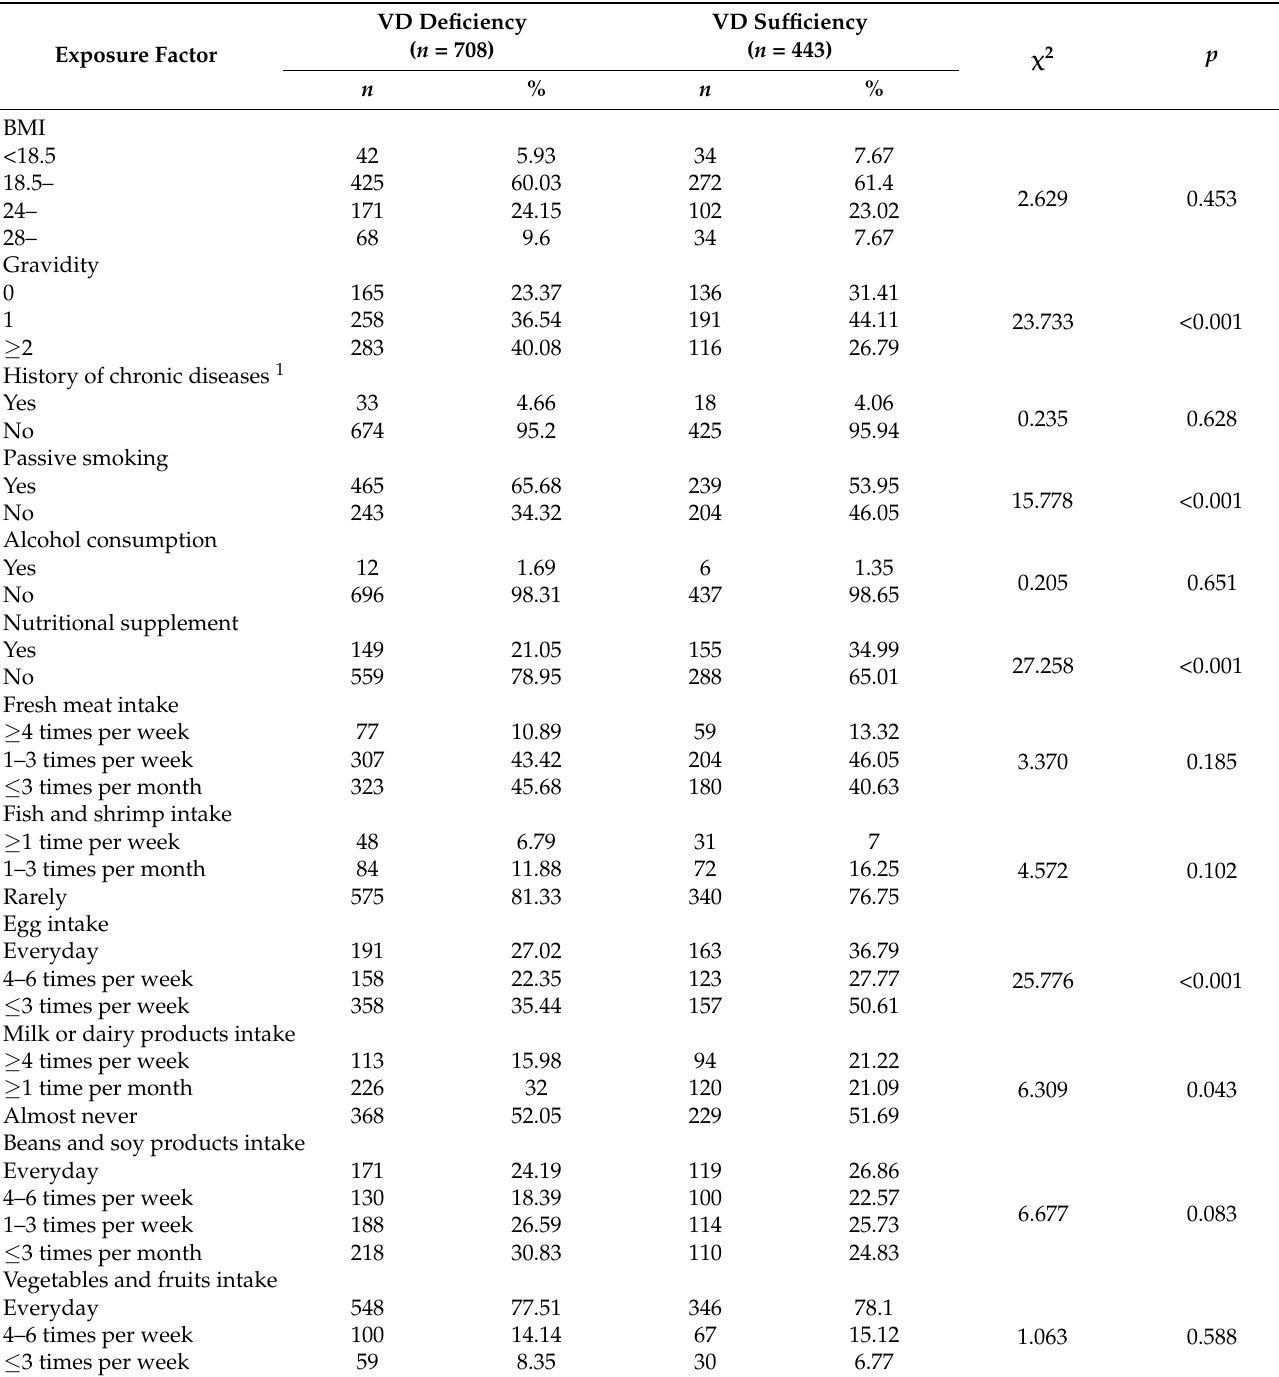
Table 2. Distribution of women’s exposure factors between VD deficiency and VD sufficiency